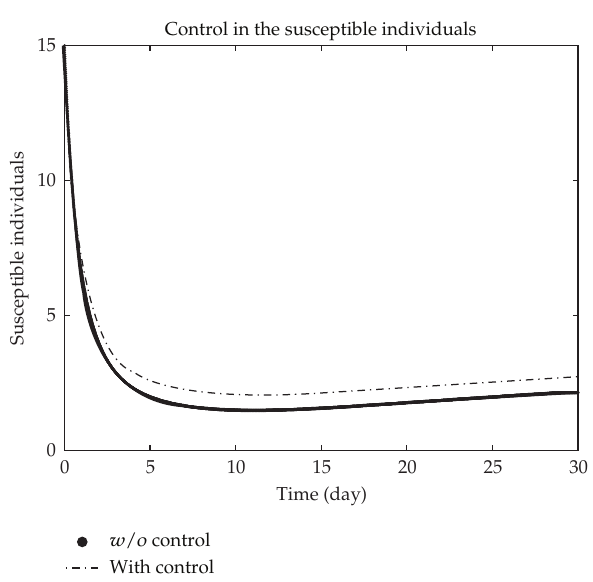
Figure 1: The plot represents the population of susceptible class with and without control.